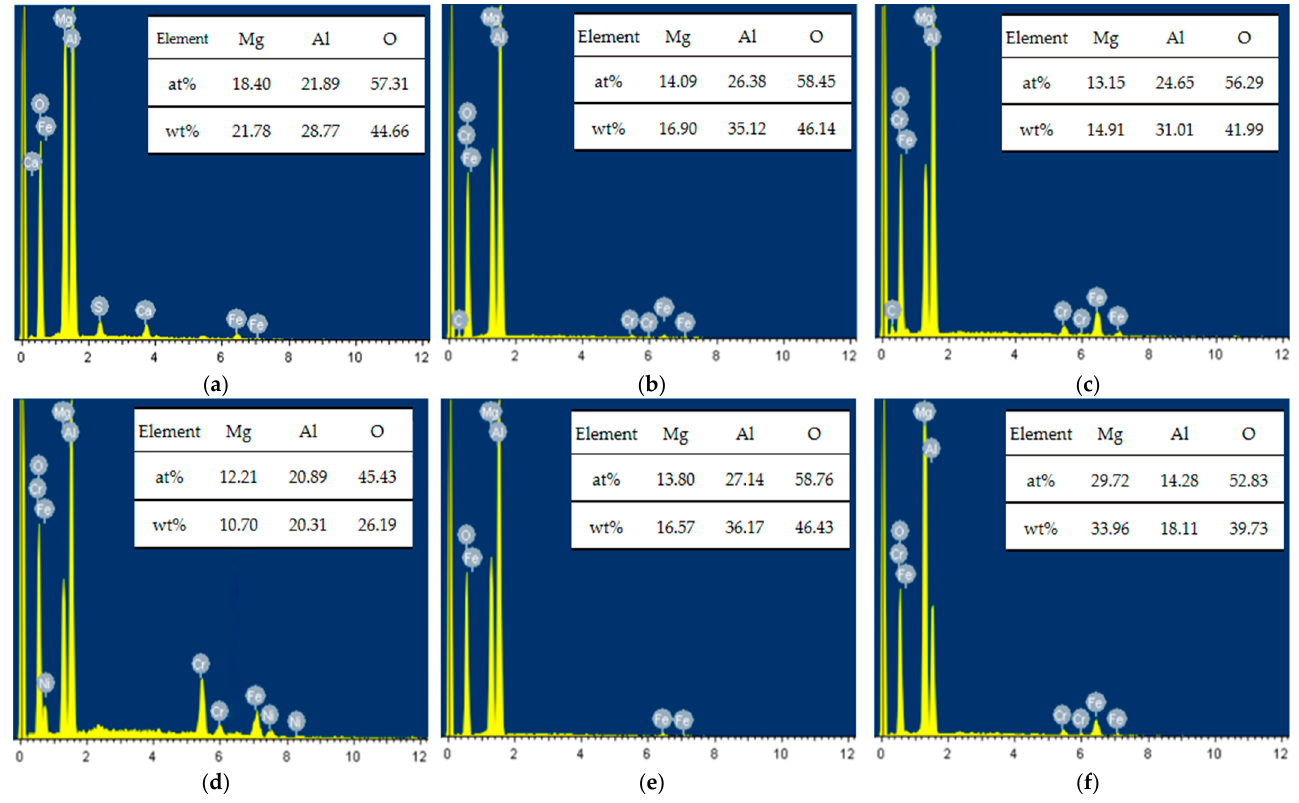
Figure 3. The EDS spectra of inclusions after different soaking durations: ( a ) 0 s; ( b ) 30 s; ( c ) 50 s; ( d ) 70 s; ( e ) 90 s; and ( f ) 110 s.